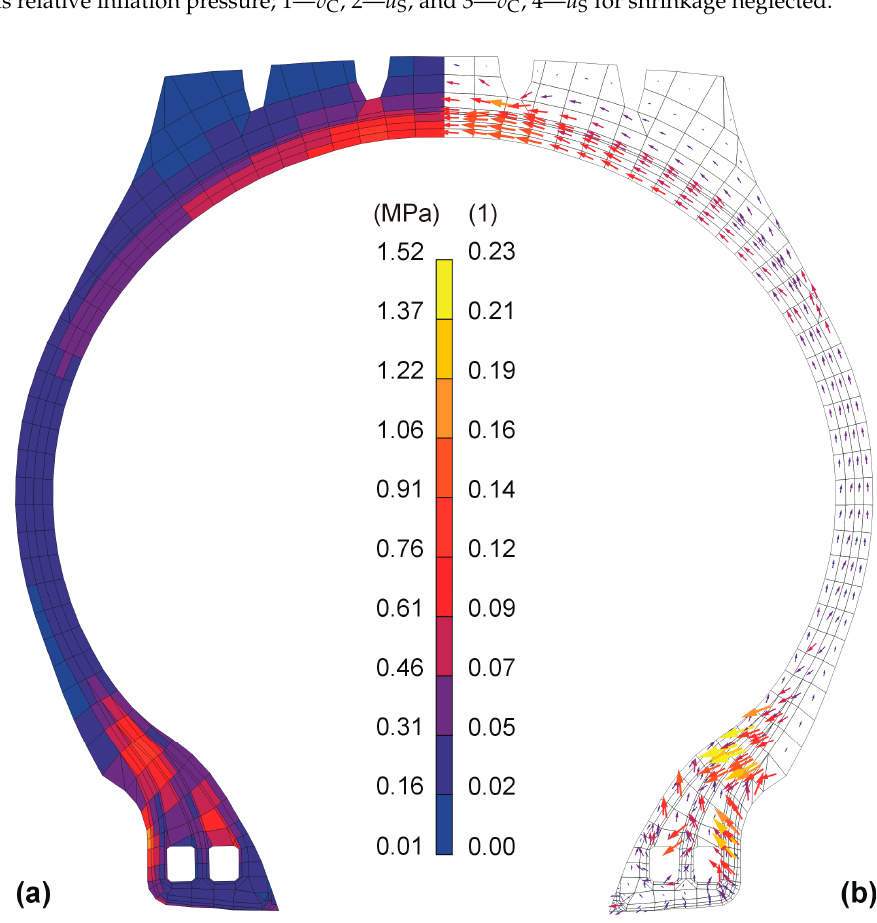
Figure 7. Displacement variation of C and S points located on inner profile of vulcanized tire in mold versus relative inflation pressure; 1 – v C , 2 – u S , and 3 – v C , 4 – u S for shrinkage neglected.